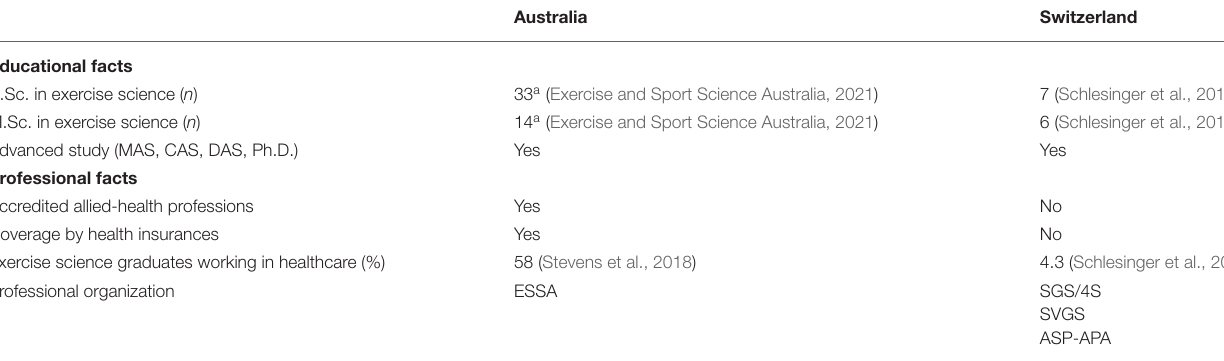
TABLE 2 | Educational and professional facts around exercise science in Australia and